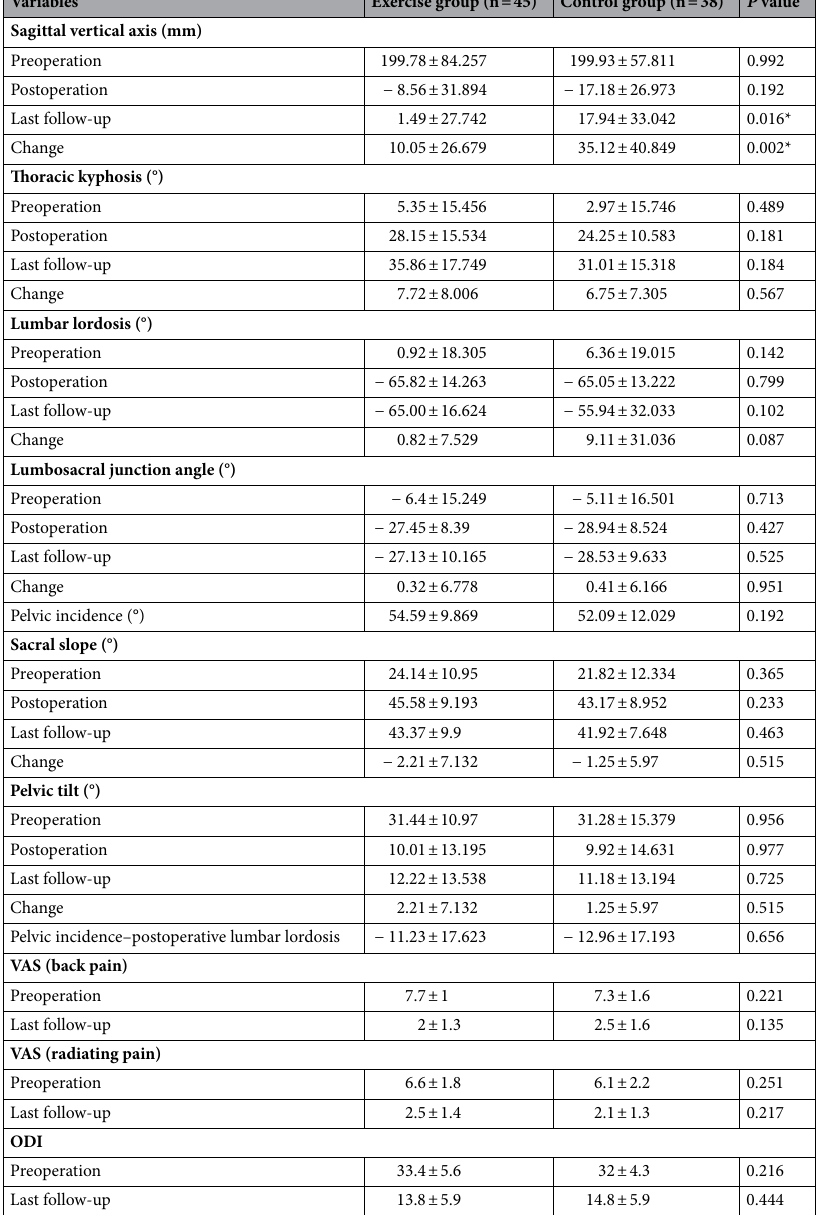
Table 2. Comparison of radiographic parameters and clinical outcomes. Data are presented as mean ± standard deviation. * p < 0.05. VAS visual analog scale, ODI Oswestry disability index.